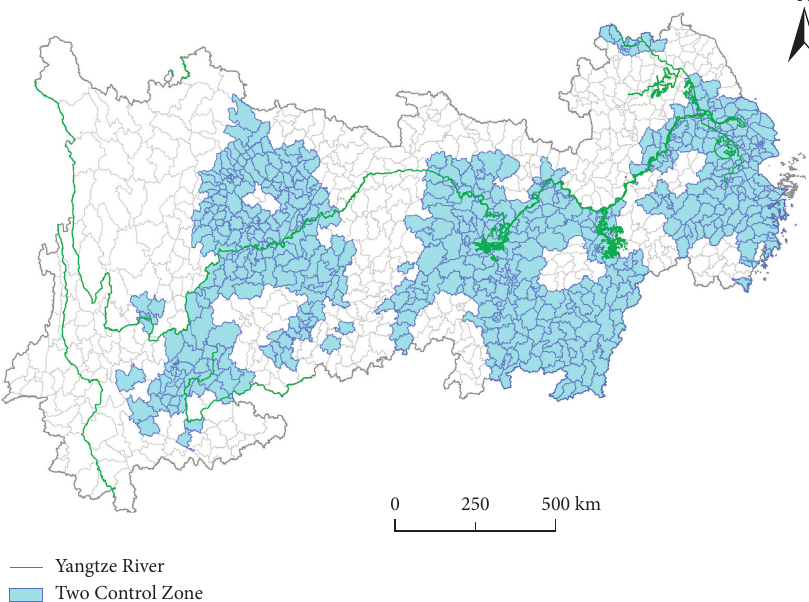
Figure 1: Geographical location of Two Control Zones in the Yangtze River Economic Belt.